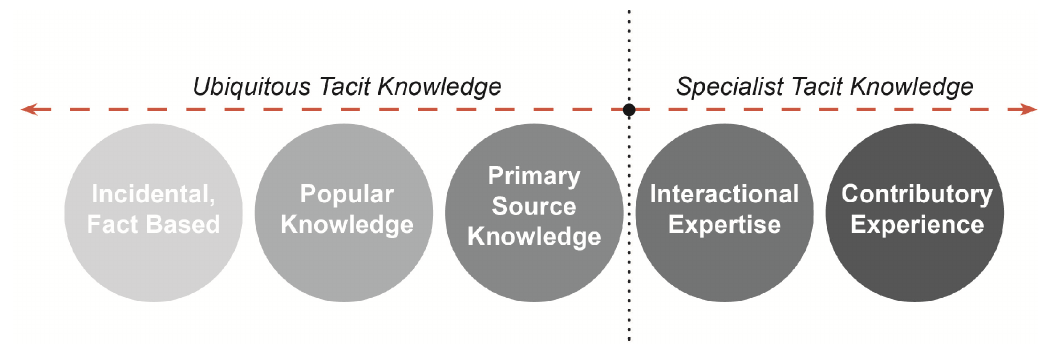
Figure 2. Specialist expertises from Evans and Collins [43].